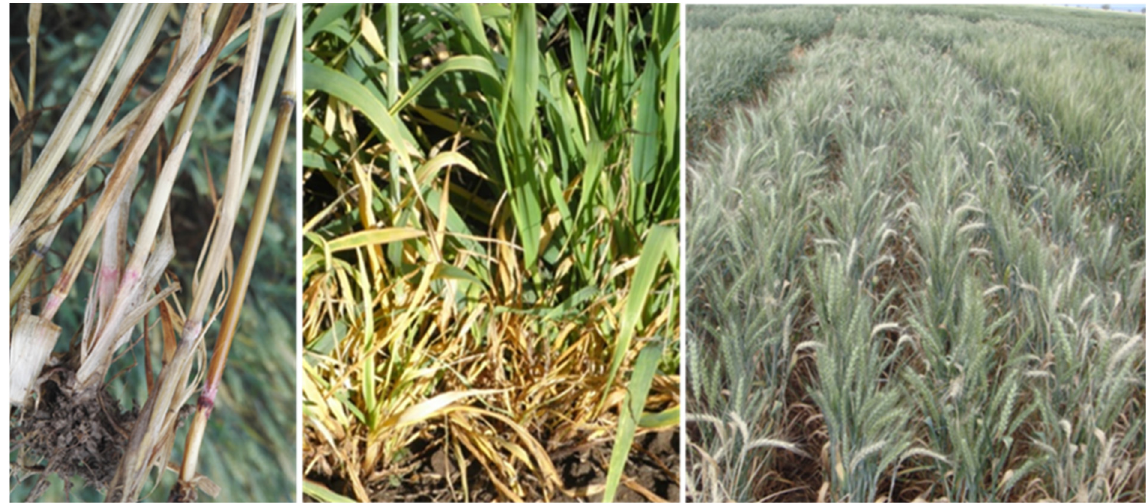
Figure 1. Symptoms of Fusarium crown rot in the field: brown necrotic lesions on tiller bases ( left ), seedling death ( middle ) and whiteheads ( right ).